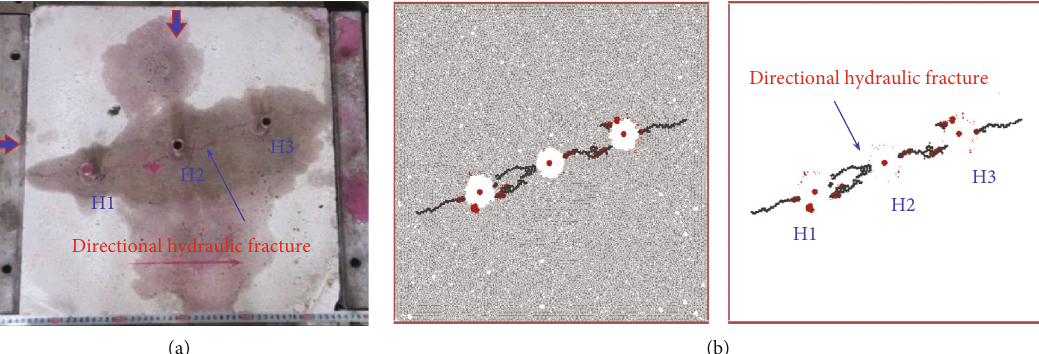
Figure 9: Comparison of laboratory test and simulation test: (a) laboratory test directional hydraulic fracture [30, 64]; (b) simulated test directional hydraulic fracture.